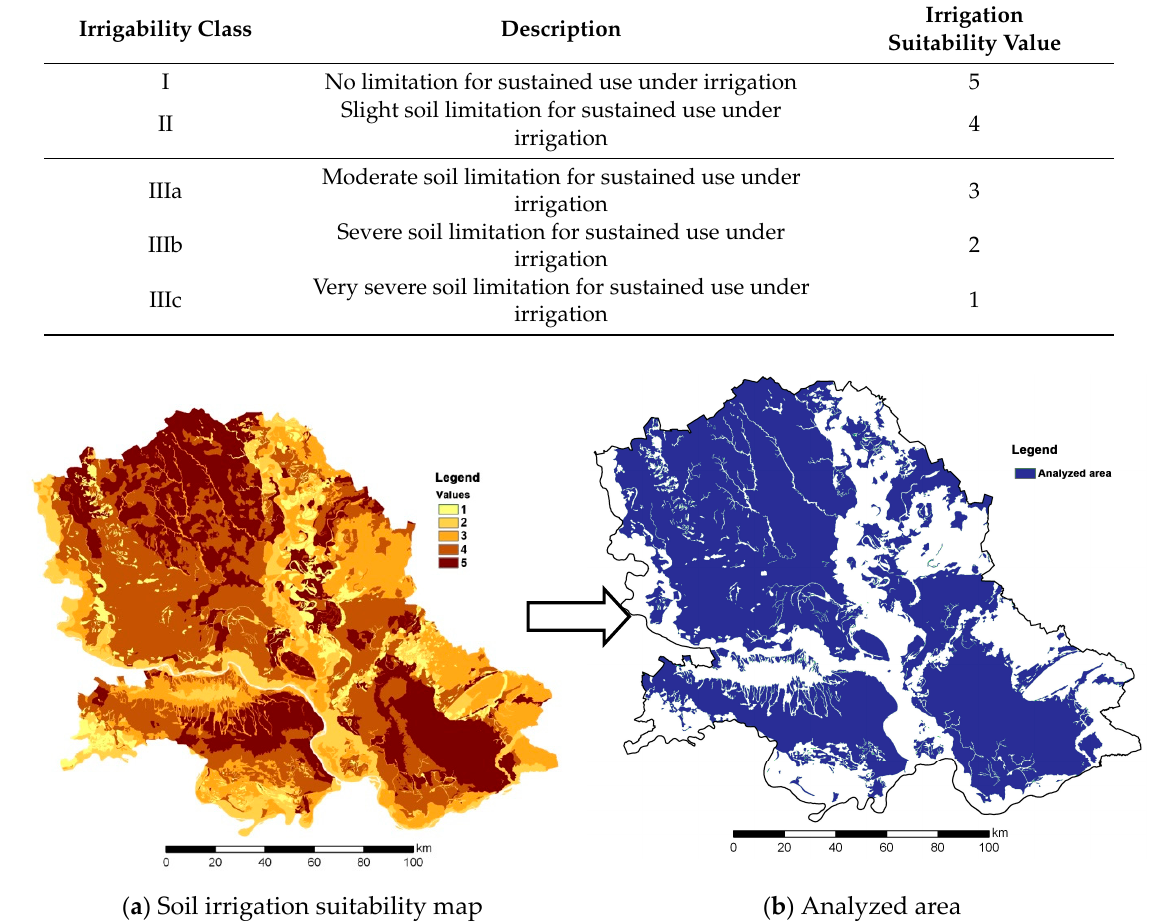
Figure 3. Defining analyzed area.